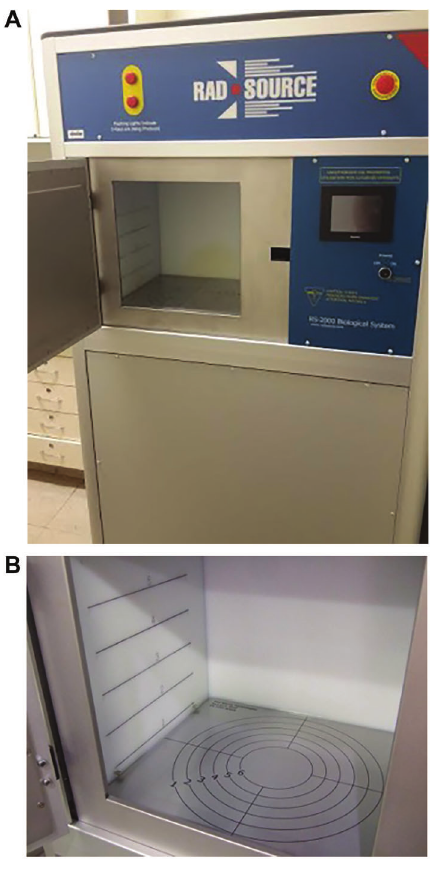
Figure 1. A , RS 2000 Irradiator. B , Irradiation chamber of the irradiator. Height levels for tray positioning (1 to 5), and the circles used for sample placement on the tray (1 to 6) are